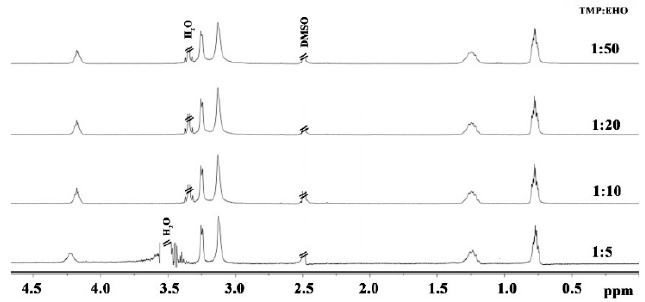
Figure 4. 1 H NMR (400 MHz, DMSO-d 6 ) spectra of the studied polyoxetanes.